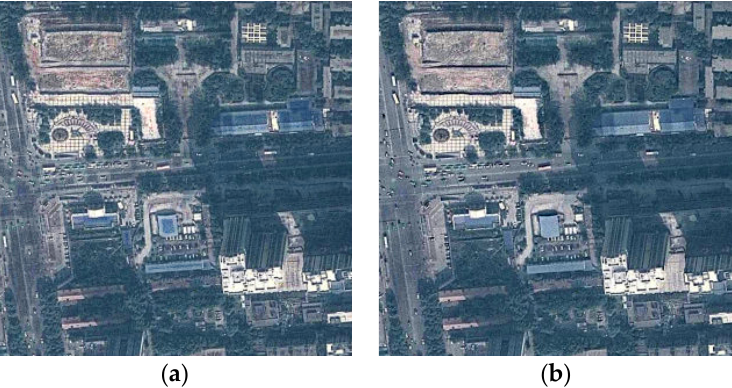
Figure 12. The halo phenomenon result. ( a ) Halo image; ( b ) image after bilateral filter.